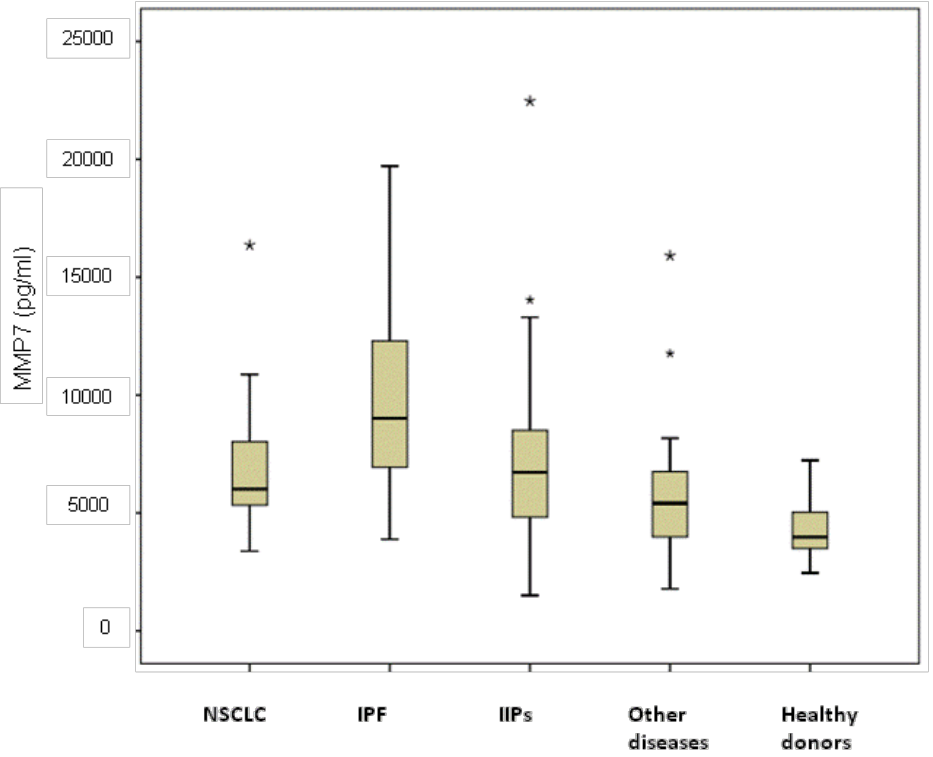
Figure 2. Serum MMP-7 levels in healthy donors and patients with different lung diseases The asterisks stand for outliers, i.e . observation points that are distant from other